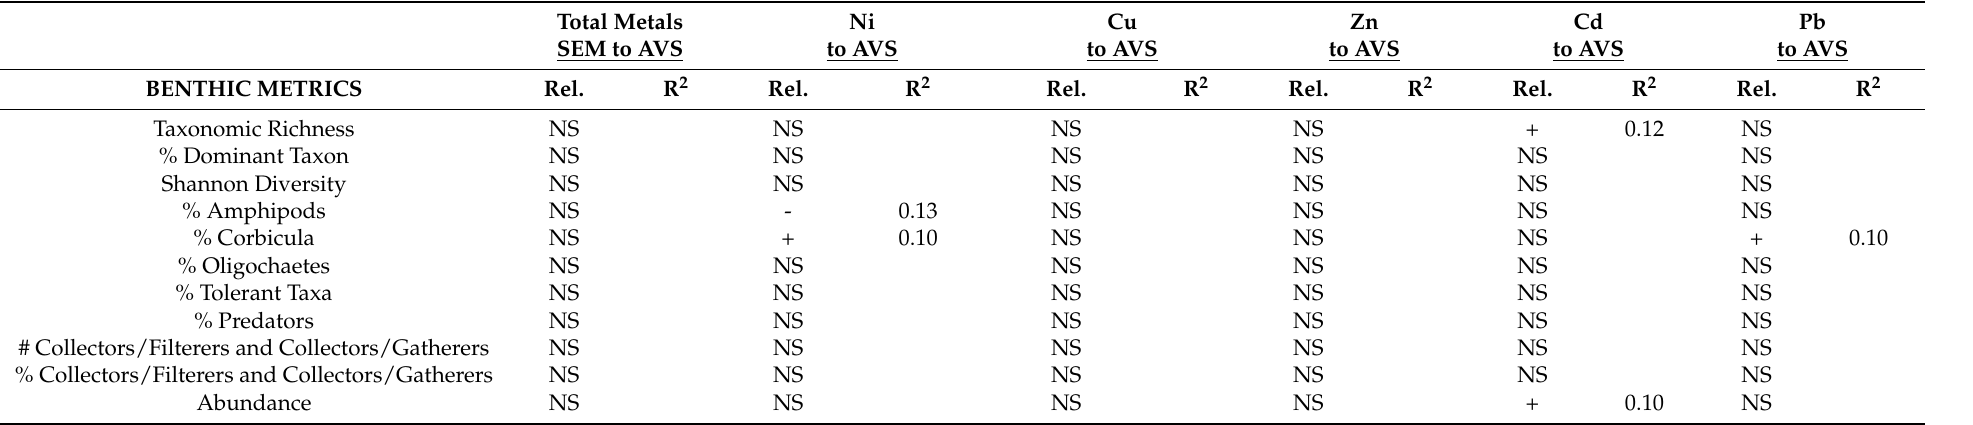
Table 3. Results of the univariate linear regression models of the benthic metrics versus concentrations of simultaneously extracted sediment metals to AVS ratios for sediments from the Cache Slough in the combined 2012, 2013, and 2014 data set, indicating the type of relationships (+ = direct; - = inverse) and R 2 values for significant relationships ( α = 0.01; NS = not